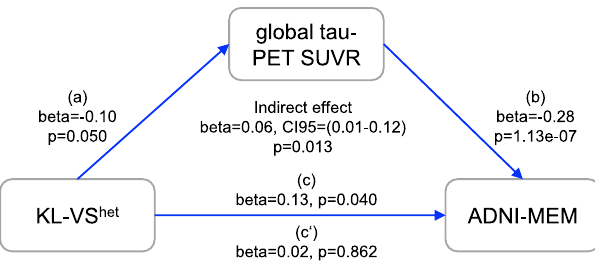
Fig. 4 Lower tau-PET levels mediate the bene fi cial association of KL-VS heterozygosity and memory in individuals with the elevated amyloid-PET burden. Path diagram of the mediation model (assessed only in amyloid- positive participants, N = 229), showing that the association between KL- VS het and better memory performance is mediated via lower global tau-PET uptake. Memory is measured by ADNI-MEM, i.e., an established memory composite score 39 . Path-weights are displayed as standardized beta values.